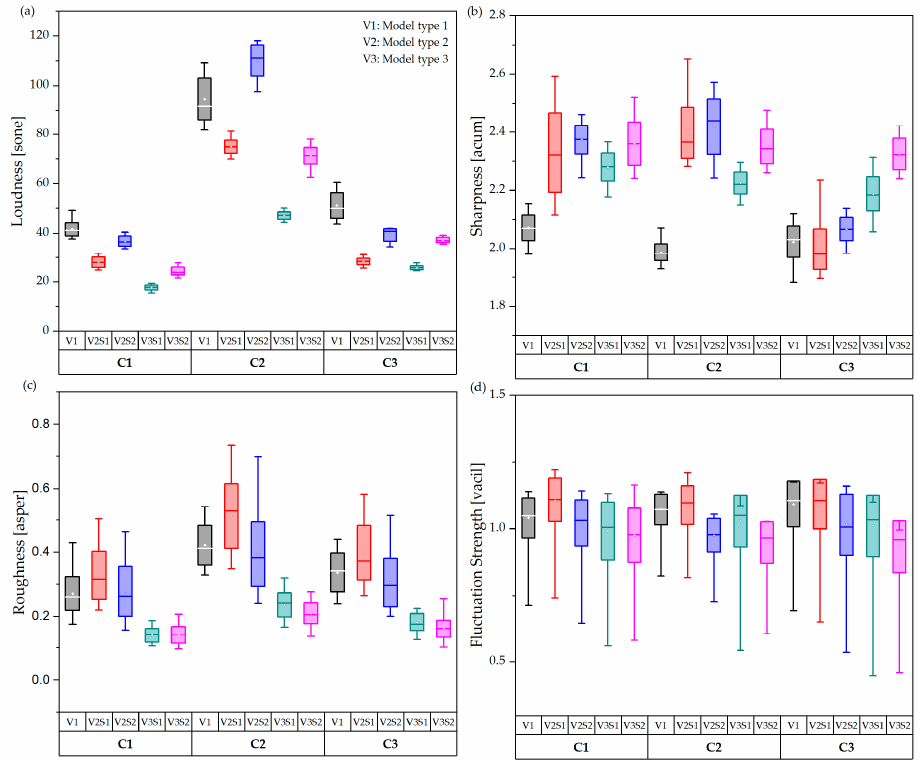
Figure 6. Comparative psychoacoustic parametric values for different vacuum cleaners with corresponding standard deviations. ( a ) Loudness, ( b ) sharpness, ( c ) roughness, and ( d ) fluctuation strength. ◊ Mean; − Median.